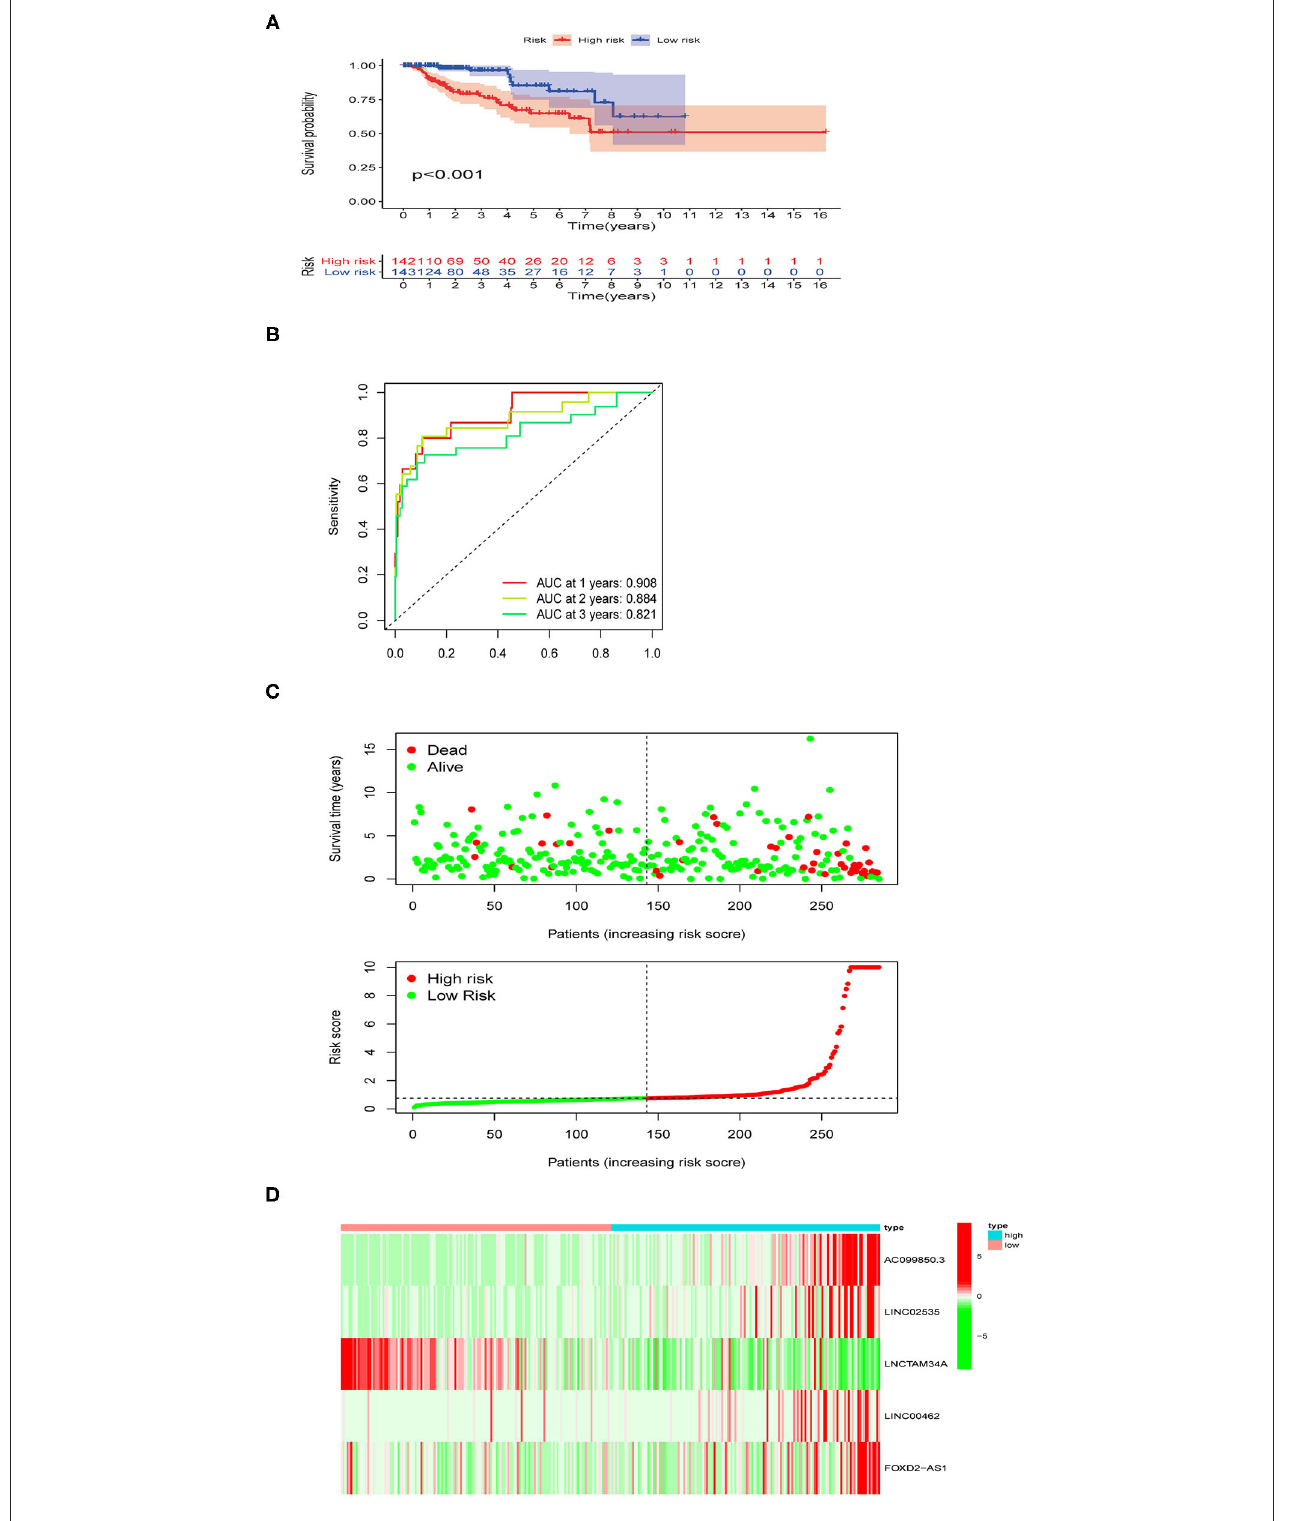
FIGURE 3 | Performance evaluation of the identified risk signature in papillary renal cell carcinoma (pRCC). (A) Kaplan–Meier overall survival (OS) curve for patients with pRCC divided into the high- and low-risk groups. (B) Receiver operating characteristic (ROC) curves exhibiting the predictive efficiency of the ferroptosis-related lncRNAs-based risk model. (C) Risk survival status plot in the high- and low-risk groups. (D) A heatmap showing the five identified ferroptosis-based lncRNAs expression profiles in two risk pRCC groups from The Cancer Genome Atlas (TCGA) database.